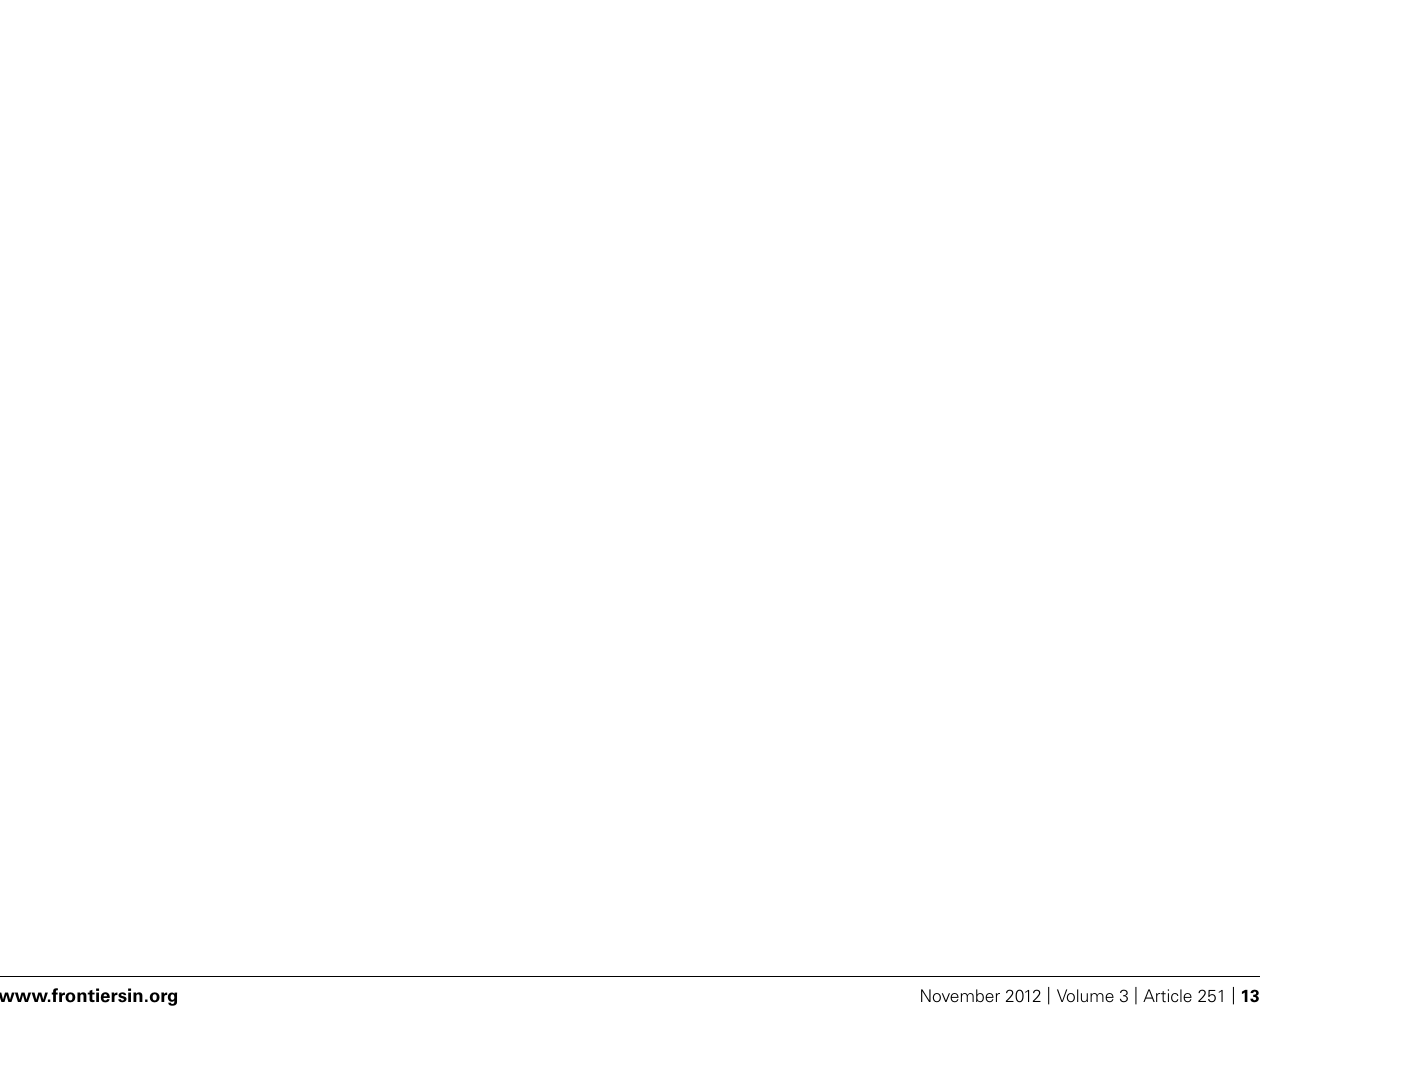
FIGUREA1 | Current traces recorded in whole-vacuole mode in vacuoles isolated from Arabidopsis mesophyll cells. (A) Current traces recorded 2 min after achieving the whole-vacuole configuration in response to voltage steps from + 80 to − 80 mV, step − 20 mV.The holding